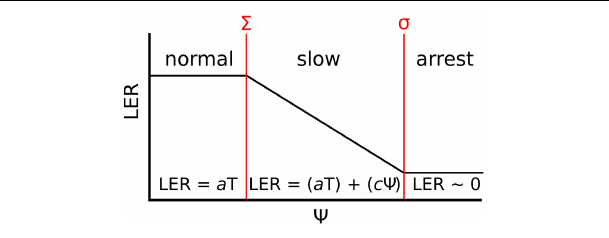
FIGURE 4 | The Tri-Phase function describing the LER under water deficit. The diagram shows three phases of LER (y-axis); “normal,” “slow,” and “arrest,” in response to increasing soil water potential (x-axis, (cid:57) ). The three phases are demarcated by two points (given in red), when growth begins to slow ( (cid:54) ) and when growth arrests ( σ ). Under normal growth ( (cid:57) < (cid:54) ), LER is attributable to the meristem temperature (T) and the genotypic response to it ( a ). When (cid:54) ≤ (cid:57) ≤ σ , LER is dependent upon a T and the genotypic response to (cid:57) ( c ). In the final arrest phase ( (cid:57) > σ ), LER equals to 0 and is therefore not dependent upon a or c